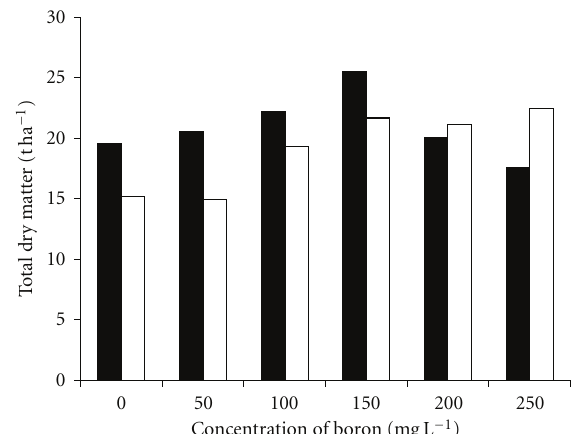
Figure 4: E ff ect of foliar applied boron on weight of 100 seed in spring (filled columns) and autumn (open columns) sunflower crops. (LSD 0 . 05 1.075 and 1.938,